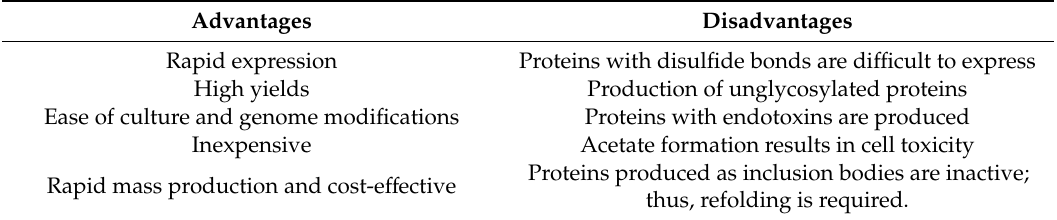
Table 1. Characteristics of Escherichia coli expression systems. Advantages Disadvantages Rapid expression Proteins with disulfide bonds are di ffi cult to express High yields Production of unglycosylated proteins Ease of culture and genome modifications Proteins with endotoxins are produced Inexpensive Acetate formation results in cell toxicity Proteins produced as inclusion bodies are inactive; Rapid mass production and cost-e ff ective thus, refolding is